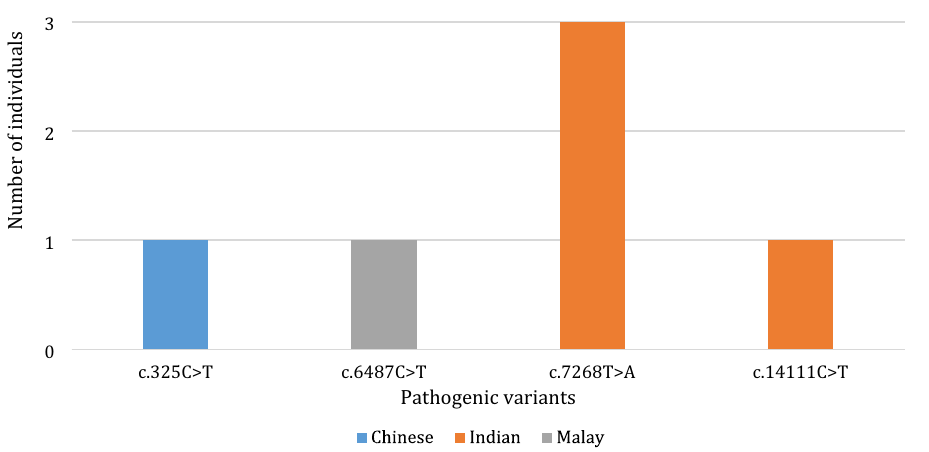
Figure 2. Ethnic distribution of individual pathogenic RYR1 variants.